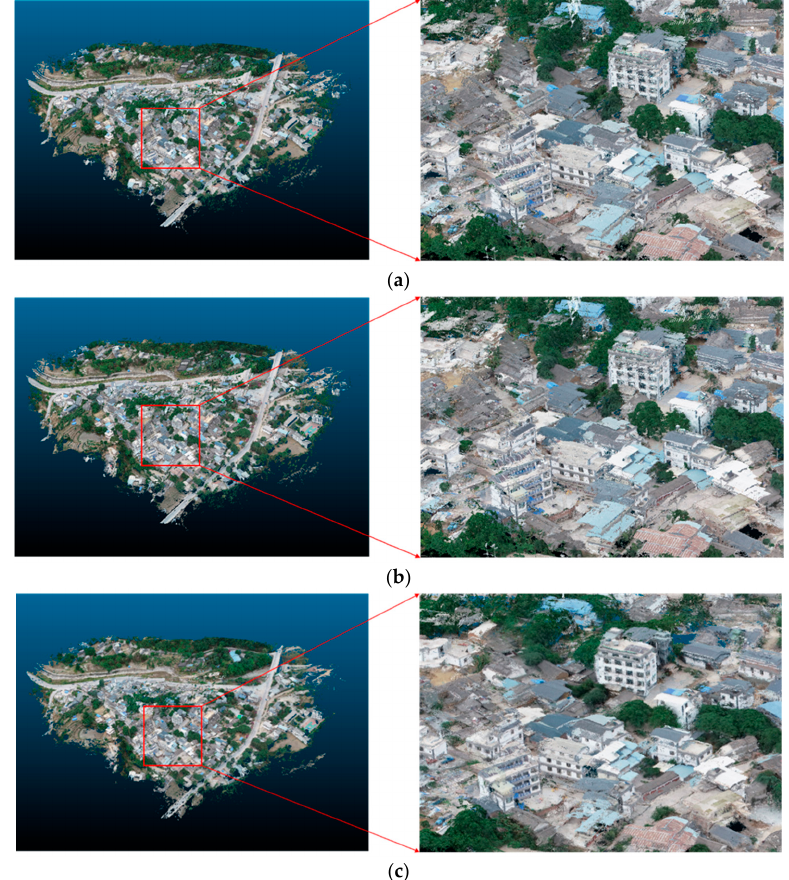
Figure 5. Visualization results of various 3D reconstruction methods. ( a ) D 2 HC-MVSNet; ( b ) AA- RMVSNet; ( c ) CasMVSNet